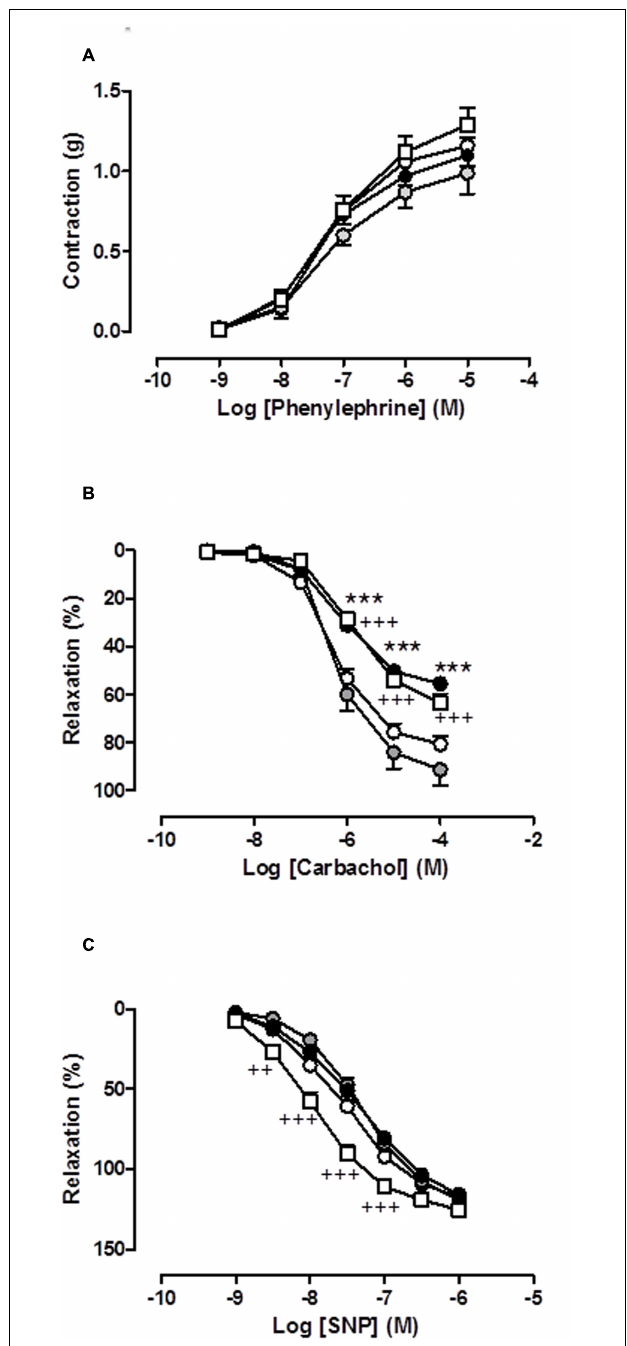
FIGURE 3 | (A) Concentration-response curve of phenylephrine (10 − 9 M–10 − 5 M), (B) concentration-response curve of carbachol (10 − 9 M–10 − 4 M), and (C) concentration-response curve of sodium nitroprusside (SNP) (10 − 9 M–10 − 6 M) in isolated rat aorta rings from animals chronically treated with saline (CONTROL, white circles) or cisplatin (CPT) 1 mg/kg (gray circles), 2 mg/kg (black circles) or 3 mg/kg (white squares). Values are expressed as mean ± SEM, n = 10–15 preparations per experimental group. A two-way ANOVA followed by Bonferroni/Dunn post hoc test was used for statistical analysis ( ∗∗∗ P < 0.001, CPT 2 mg/kg vs. control; ++ P < 0.01, +++ P < 0.001 CPT 3 mg/kg vs.